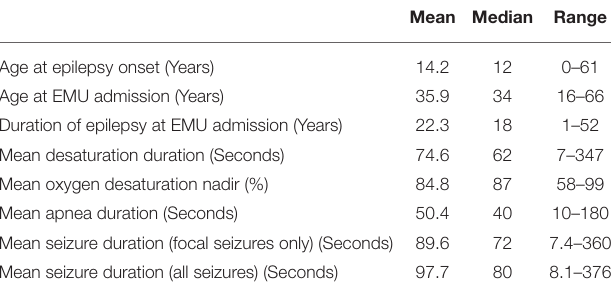
TABLE 2 | Summary data including all focal and FBTC